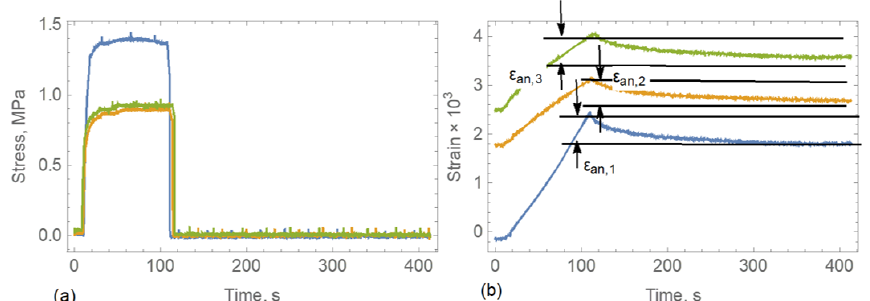
Figure B5. Stress and strain versus time in three LU tests performed with the same core of columnar ice (ice temperature is 5 ◦ C).